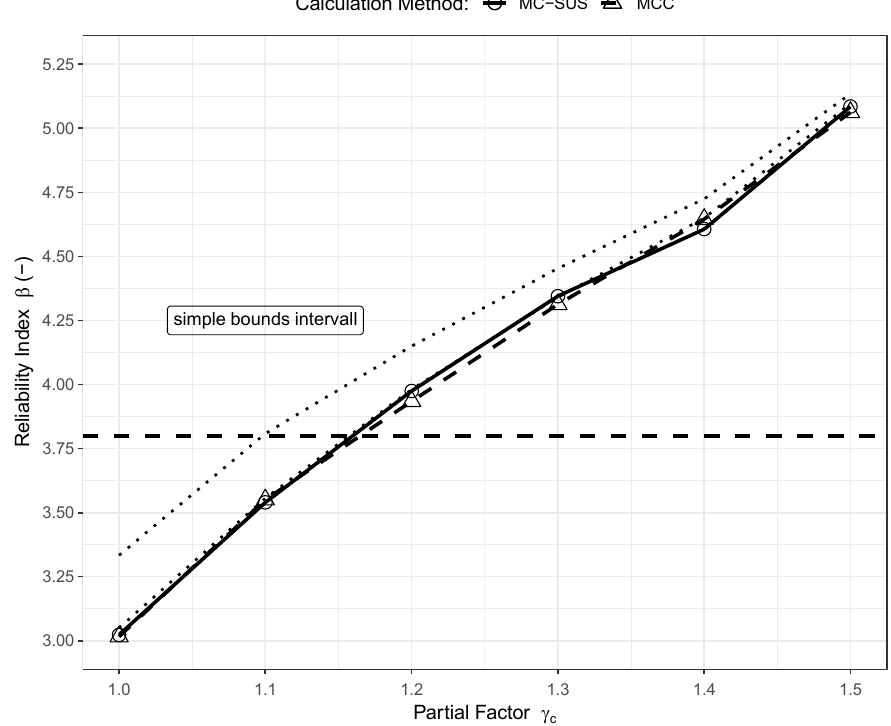
Figure 8. Sensitivity analysis: variation in the safety level in relation to the partial factor (reinforce- ment area of 4000 mm 2 ).